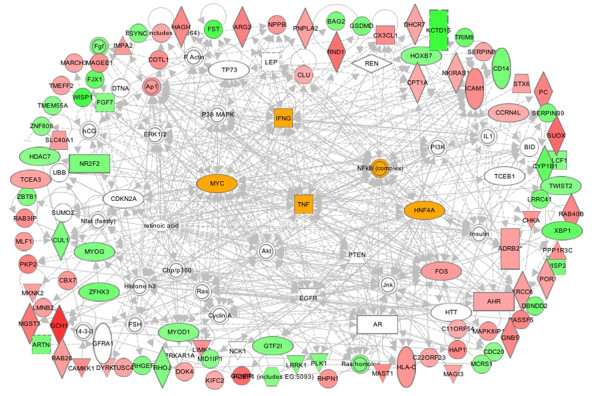
The major gene networks specifically modulated by CBHA at 6h. The IPA merged the top seven networks of CBHA-elicited genes into a single network. The dominant nodes of IFNγ, HNF-4A, TNFα and MYC connected extensively to the signaling node of NFkB are highlighted. The major gene networks are either directly (solid lines) or indirectly (broken lines) connected to PI3K- and MAPK-specific signaling pathways. The up regulated genes are shown in pink and red while down-regulated genes are depicted in green.